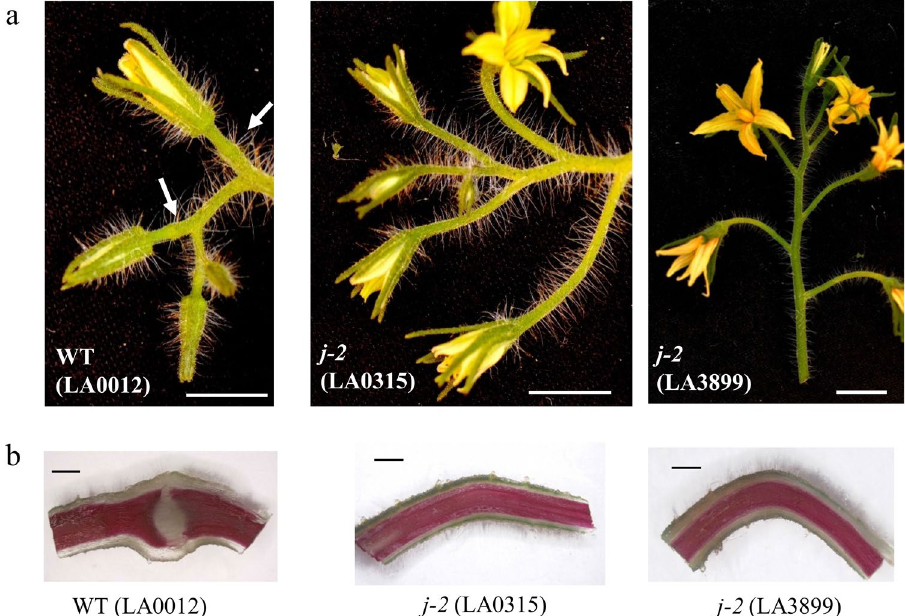
Figure 1. Phenotypes of the j-2 tomato mutants. ( a ) Inflorescences of WT var. Pearson (LA0012), j-2 (LA0315) and j-2 (LA3899) mutants are shown. White arrows indicate abscission zone in WT plants. Scale = 1 cm. ( b ) Longitudinal sections of flower pedicels stained with phloroglucinol, showing the presence of the AZ in WT and not in the j-2 mutants. Scale = 2 mm.